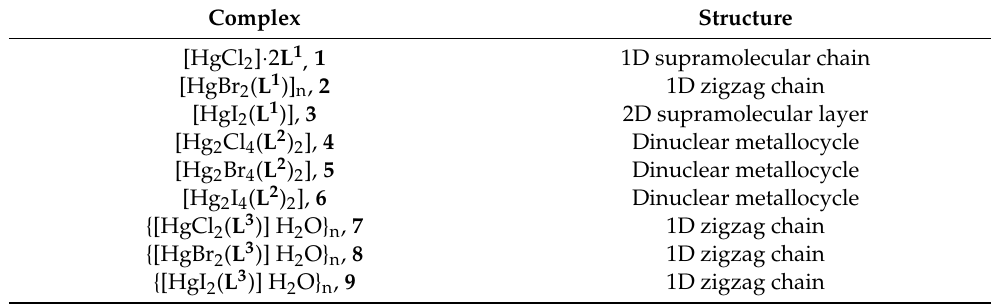
Table 4. Structural types of 1 – 9 .